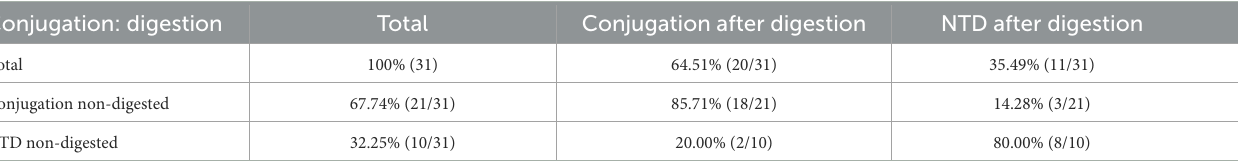
TABLE 2 Ability to conjugate in liquid